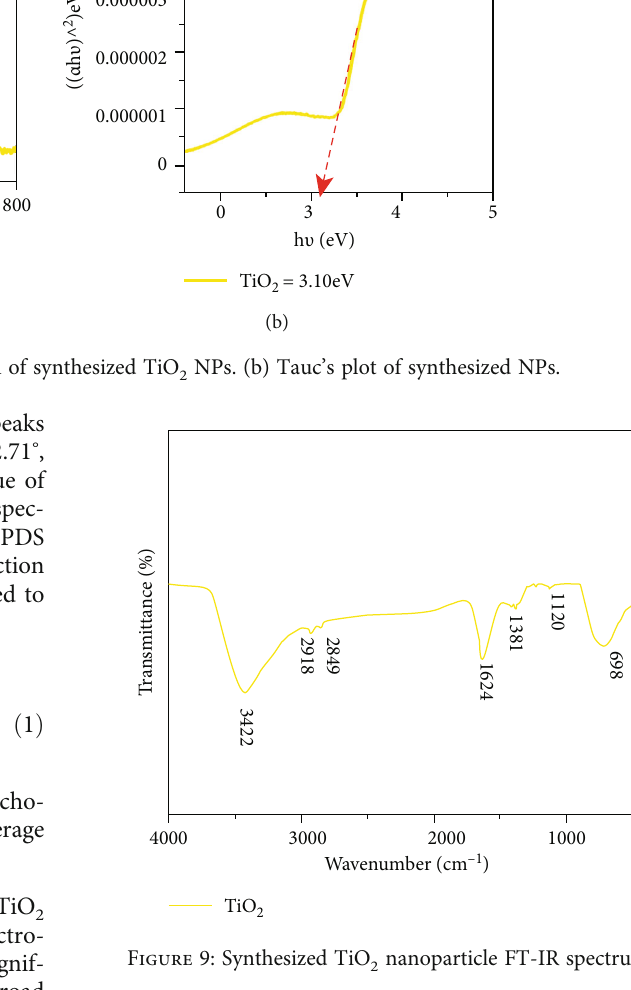
nanoparticle FT-IR 2